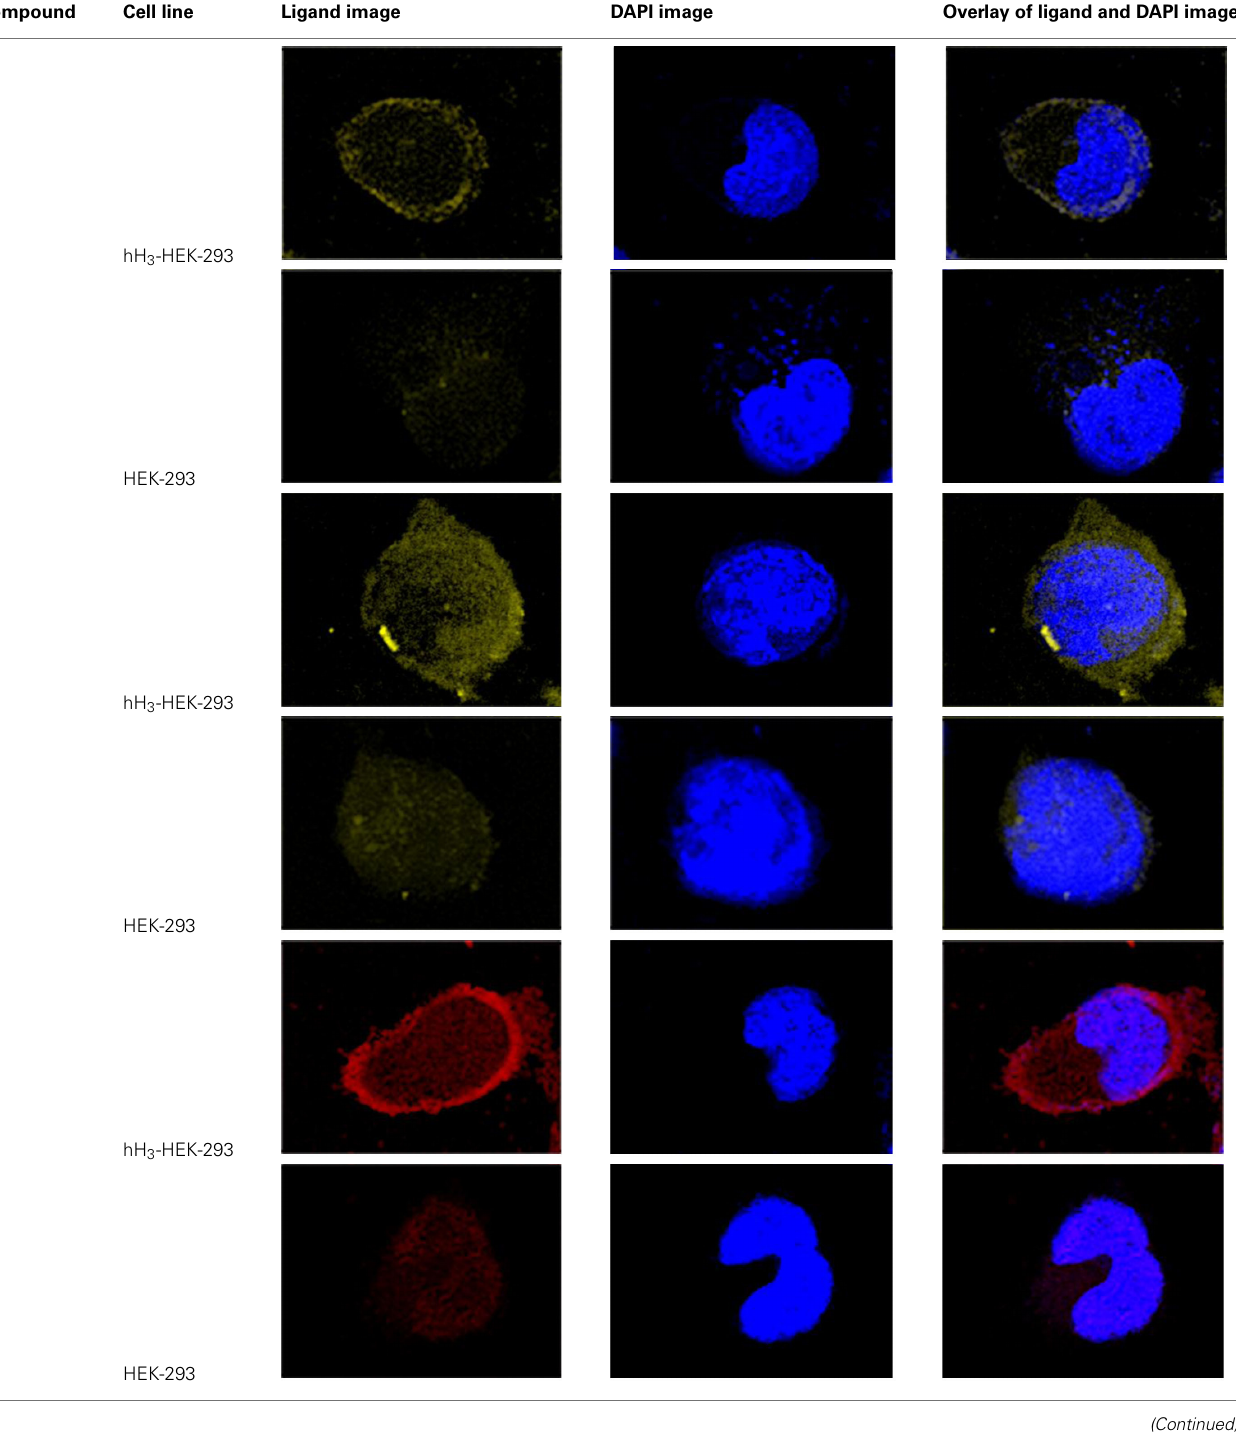
TableA1 | Fluorescence images of fluorescent compounds.